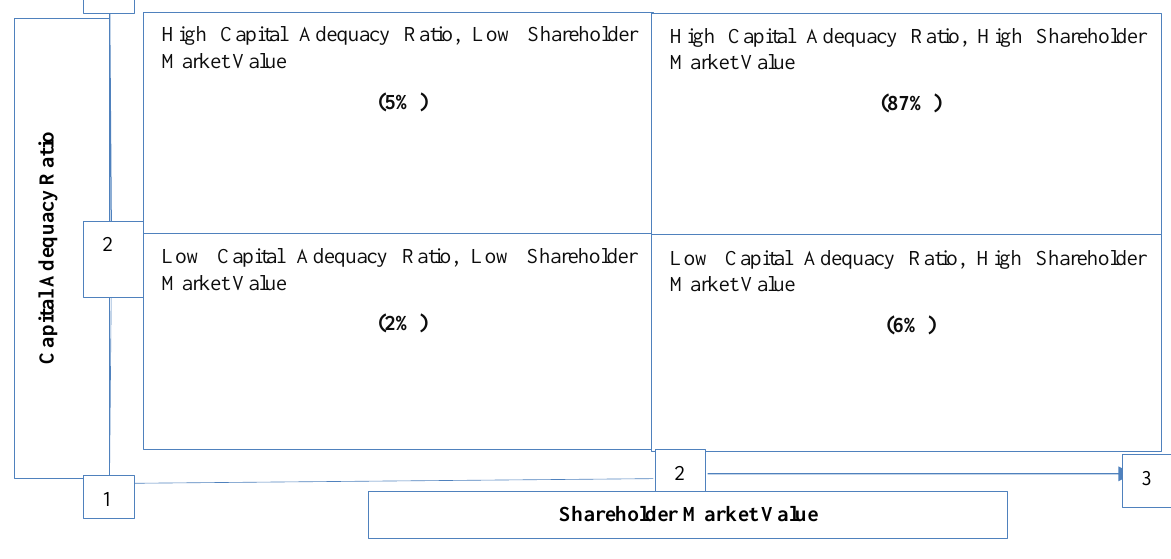
Figure 4: Typology of capital adequacy ratio and shareholder market value